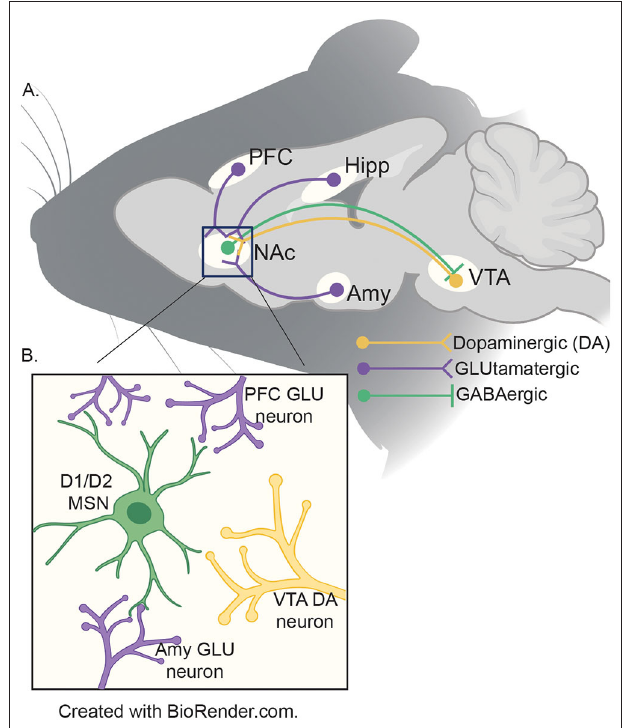
FIGURE 1 | (A) Schematic of reward circuitry in rodent brain. The NA receives dopaminergic projections (yellow) from the ventral tegmental area (VTA) and glutamatergic (purple) inputs from the prefrontal cortex (PFC), ventral hippocampus (HIPP) and basolateral amygdala (AMY). GABAergic (green) neurons from the NAc project to the VTA by both direct (D1) and indirect (D2; via the ventral pallidum - not shown) pathways. (B) Presynaptic inputs to the NAc medium spiny neurons (MSNs). The two major neuronal cell types found in the NAc are D1- and D2-MSNs (green) which integrate information from the VTA (yellow), PFC, HIPP and AMY (purple) to coordinate the appropriate behavioral responses to salient